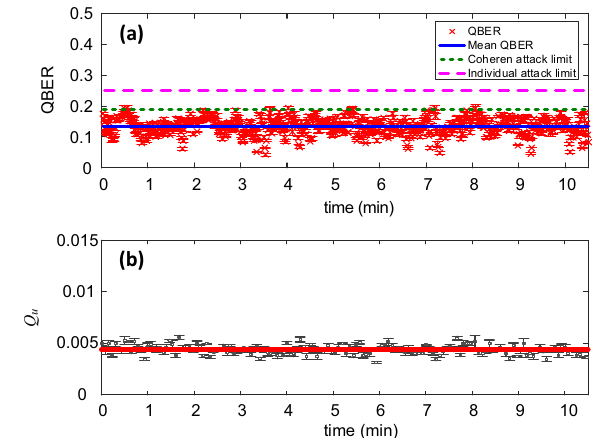
Fig. 4 Experimental results. a QBER for 10 min of acquired data. The blue line represents the average QBER about 13%, which is well below the limits of both coherent attach and individual attacks. b Measured value of the signal-state gain Q u . The average value of